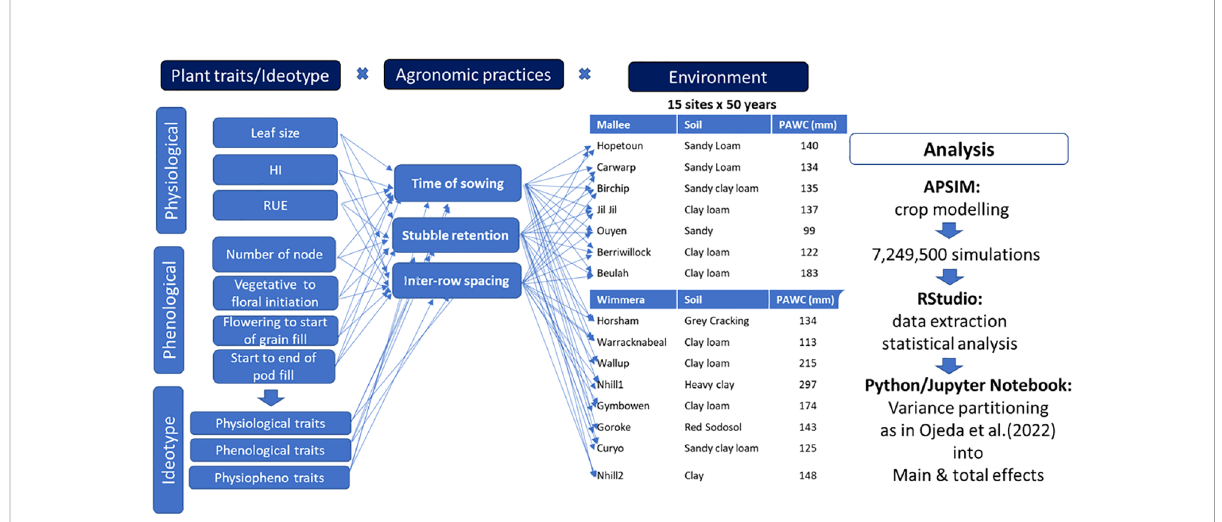
FIGURE 1 Framework of ideotype x argonomic practices x environmental analysis for plant traits optimization in